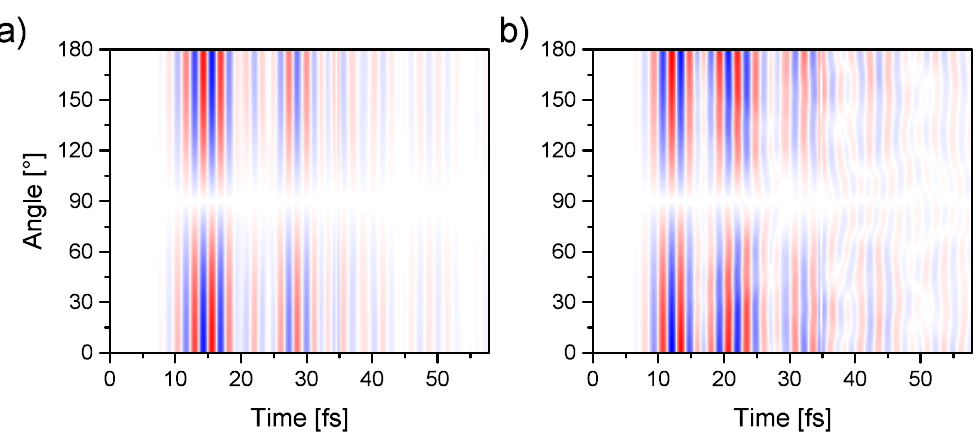
Figure 5. Evaluation of the electric field on the sandwich surface along a ring with radius ( a ) 22nm and ( b ) 48nm showing the volume mode in the inside and the ring modes in the outside appearing after around 35fs.